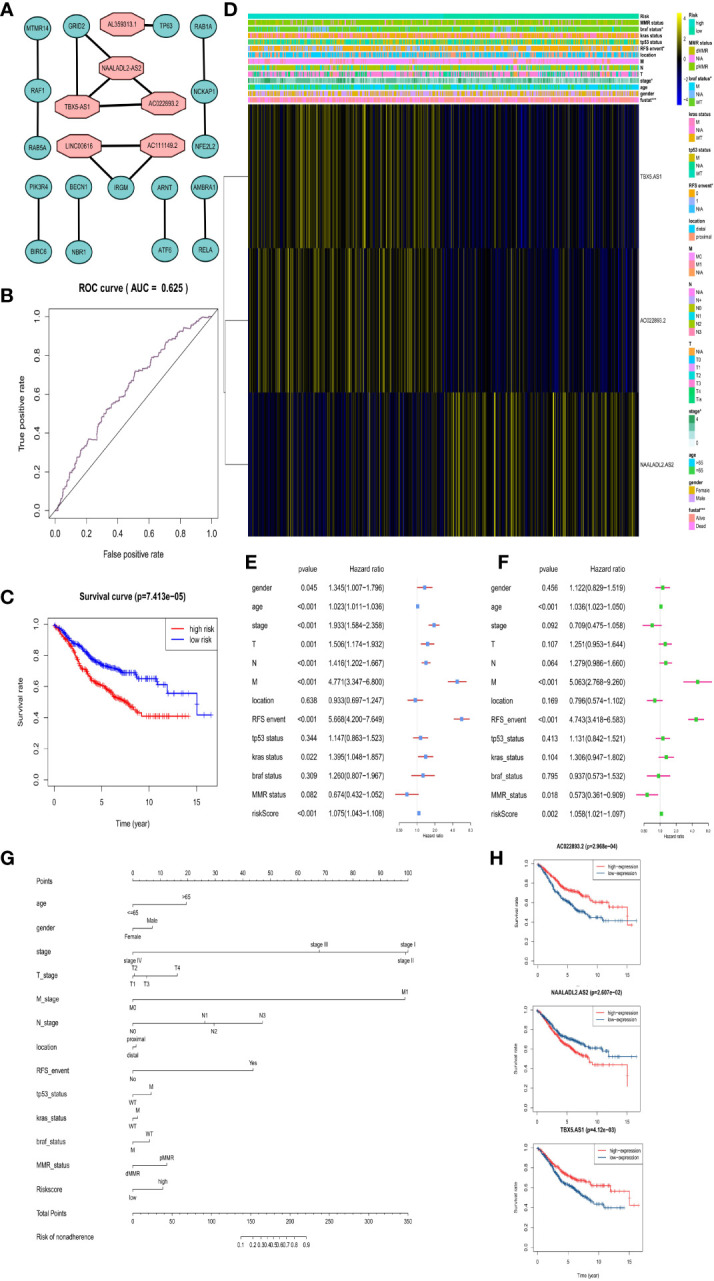
Risk prognosis model construction of three prognostic risk-related DAR-lncRNAs in GEO data. (A) Co-expression network diagram of DAR-lncRNAs and DEAGs in the Cytoscape. (B) ROC curve of risk prognosis model in the training set by R package “survivalROC”. (C) Survival curve comparing high-risk and low-risk groups by R package “survival”. (D) Heat map of prognostic DAR-lncRNAs and clinical parameters at high-risk and low-risk groups by R package “pheatmap”. (E) The univariate cox forest map of clinical characteristics in the training set by R package “survival” and “forestplot”. (F) The multivariate cox forest plot of clinical characteristics in the training set by R package “survival” and “forestplot”. (G) The nomogram baseline of multivariate cox analysis by R package “rms”. (H) The survival curve of three prognostic risk-related DAR-lncRNAs by R package “survival”. *P < 0.05, **P < 0.01, ***P < 0.001, and ****P < 0.0001.